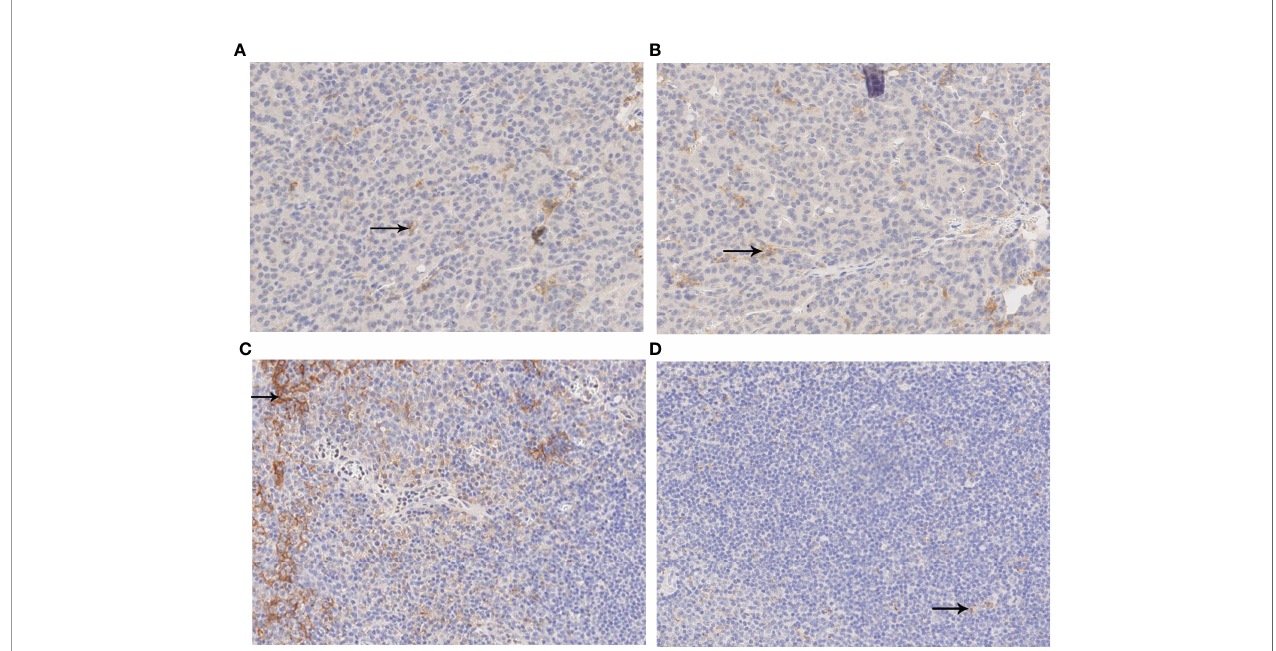
FIGURE 1 | PDL1 immunohistochemical analysis. (A, B) Immunohistochemical analysis of PDL1. The percentage of positive-stained cells was 1% (X200); (C) Positive control image of immunohistochemical analysis of PDL1 (X200). (D) Negative control imaging of immunohistochemical analysis of PDL1 (X200). PDL1, programmed cell death ligand 1.